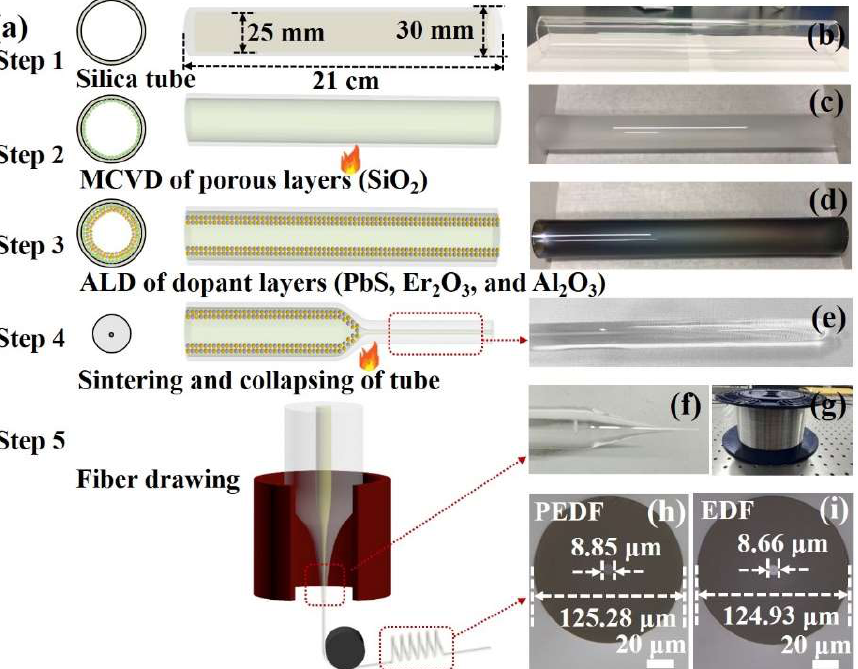
Figure 6. ( a ) Schematic diagram of fiber fabrication process; ( b ) silica tube after HF solution treatment; ( c ) silica tube after deposition of SiO 2 porous soot layers; ( d ) silica tube after ALD process; ( e ) optical fiber preform; ( f ) fiber preform after drawing; ( g ) fiber samples; ( h ) the cross section of PEDF; ( i ) the cross section of EDF.